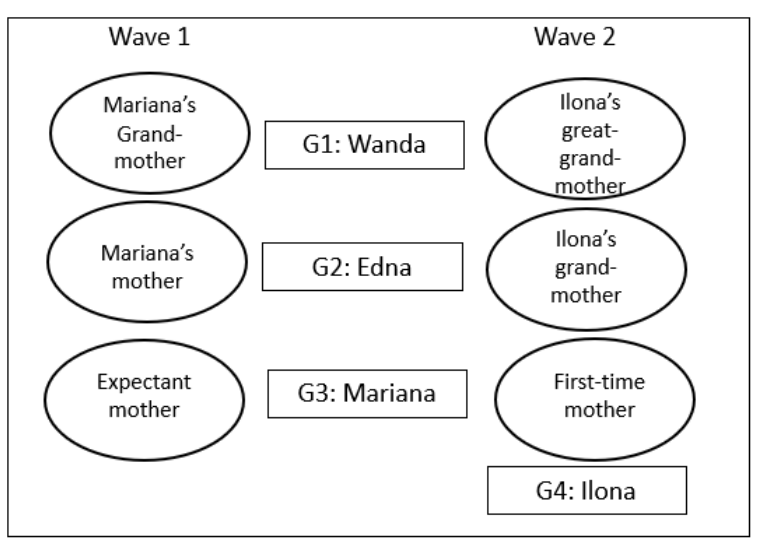
Figure 3 : Kowalski family